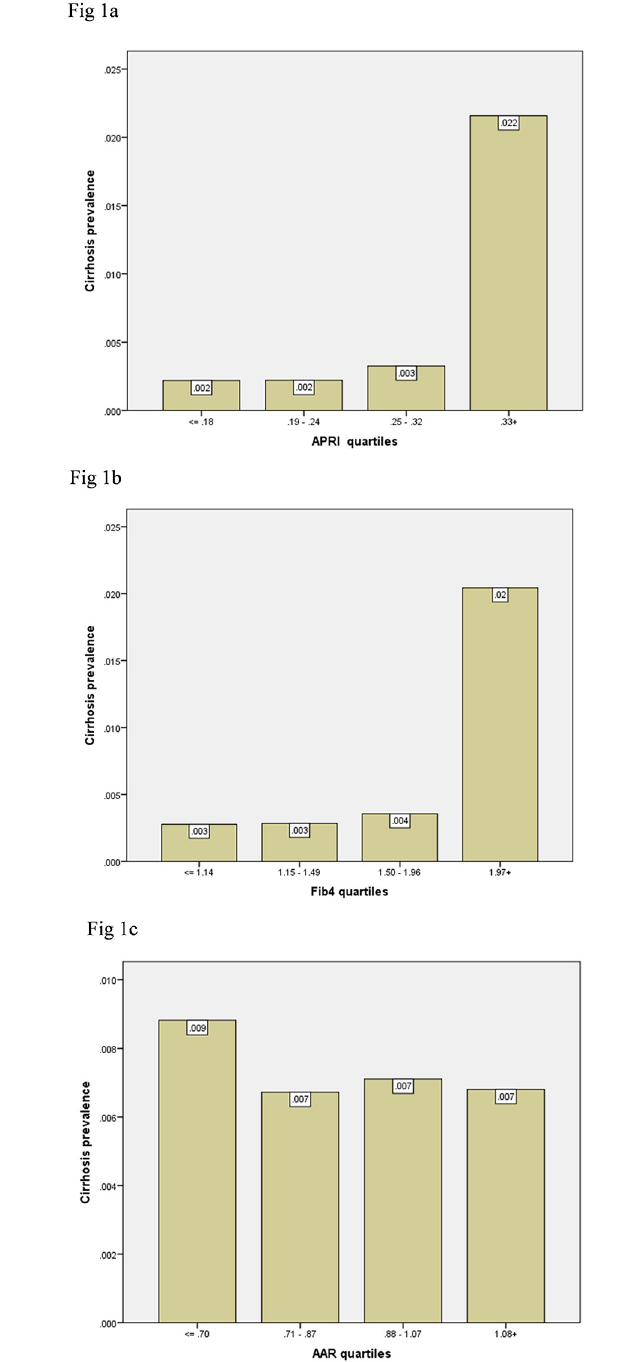
Fig 1. a—cirrhosis prevalence by quartiles of fibrosis test results by APRI; b- cirrhosis prevalence by quartiles of fibrosis test results by FIB-4; c—cirrhosis prevalence by quartiles of fibrosis test results by AAR.